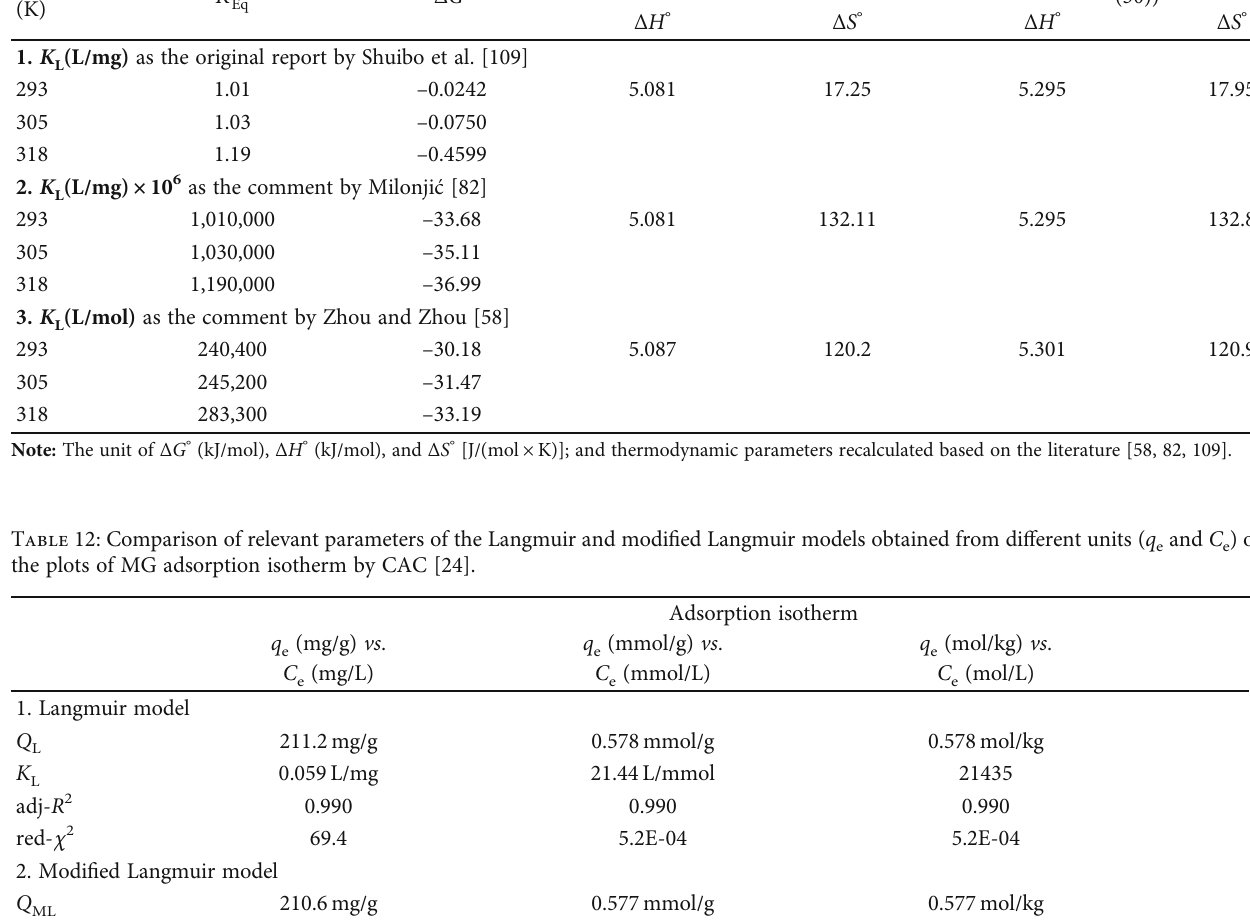
Table 11: Comparison of thermodynamic parameters for the adsorption process of U(VI) on hematite obtained from di ff erent calculation methods.